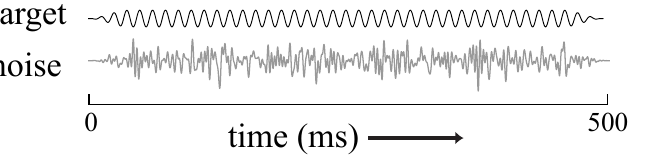
Figure 1. A schematic represtentation of the stimuli presented in Experiment 1. Details are provided in the